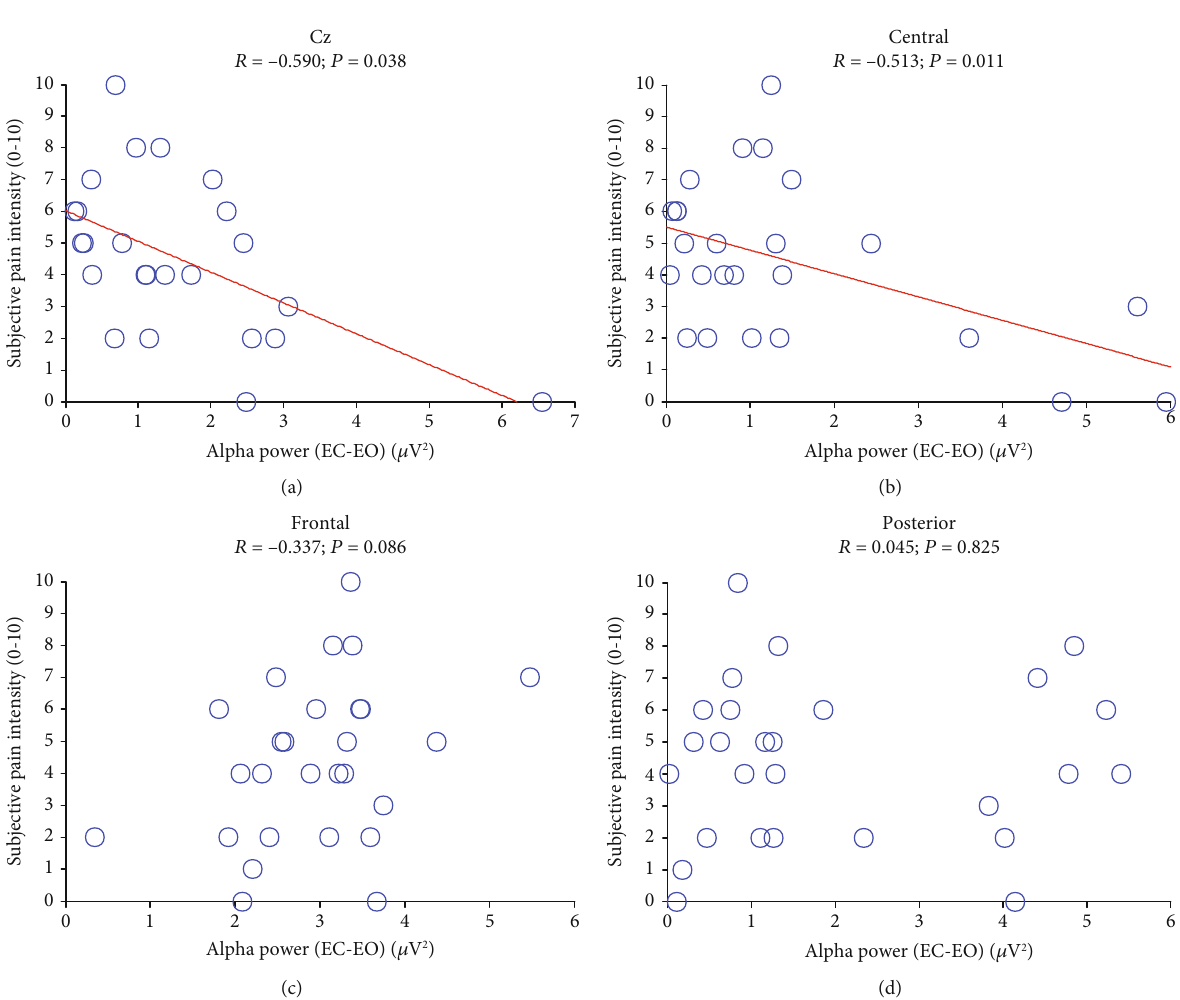
Figure 6: Relationships between alpha power reduction from eyes-closed (EC) condition to eyes-open (EO) condition and subjective intensity of pain perception in (a) central ( R = − 0 : 513 , P = 0 : 011 ), (b) Cz electrode ( R = − 0 : 590 , P = 0 : 038 ), (c) frontal ( R = − 0 : 337 , P = 0 : 086 ), and (d) posterior ( R = 0 : 045 , P = 0 : 825 )